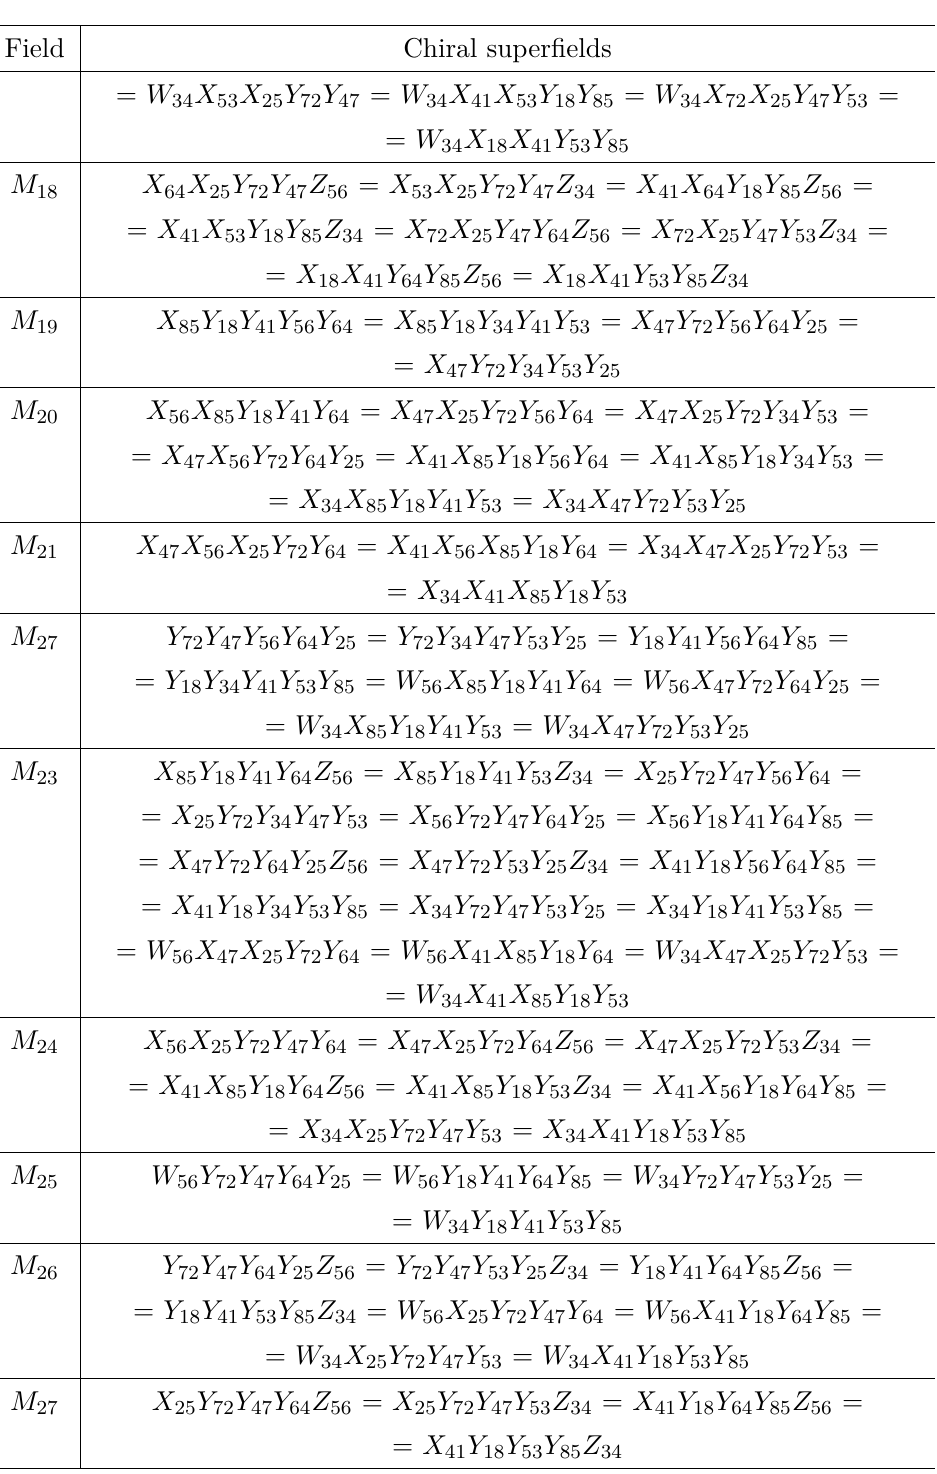
Table 7. Generators of Q 1 , 1 , 1 / Z 2 in Phase